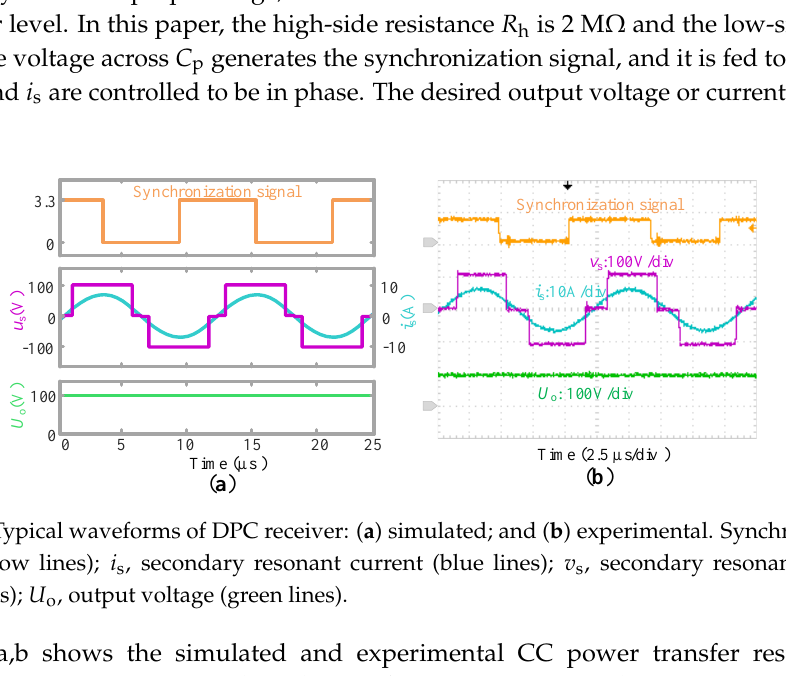
Figure 11. Simulated and experimental CC power transfer results of DPC system: ( a ) simulated; and ( b ) experimental. I o , output current (blue lines); U o , output voltage (green lines). I o :2A/div U o : 50V/div Time (0.25 s/div ) R L : 25 Ω to 50 Ω 01 2 3 5 0 50 ( b ) 100 4 Figure 12. Simulated and experimental CV power transfer results of DPC system: ( a ) simulated; and ( b ) experimental. I o , output current (blue lines); U o , output voltage (yellow lines). 4.2. Analog Phase Control